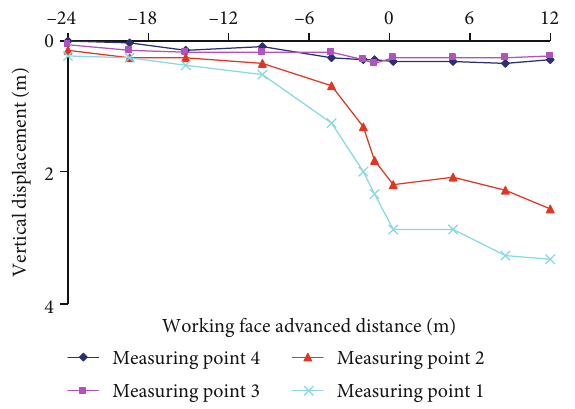
Figure 6: The variation in displacement at the measuring